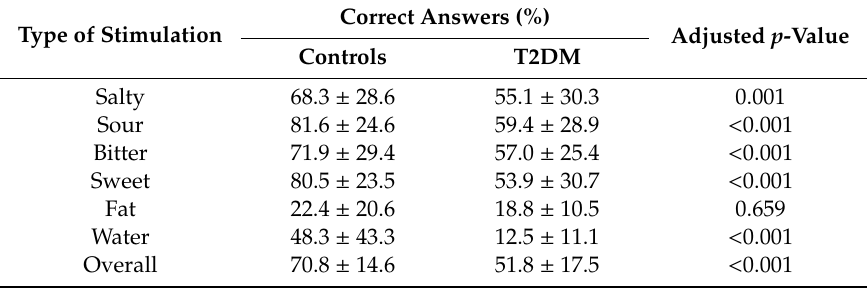
Table 4. Comparison of taste function between control subjects and T2DM patients.